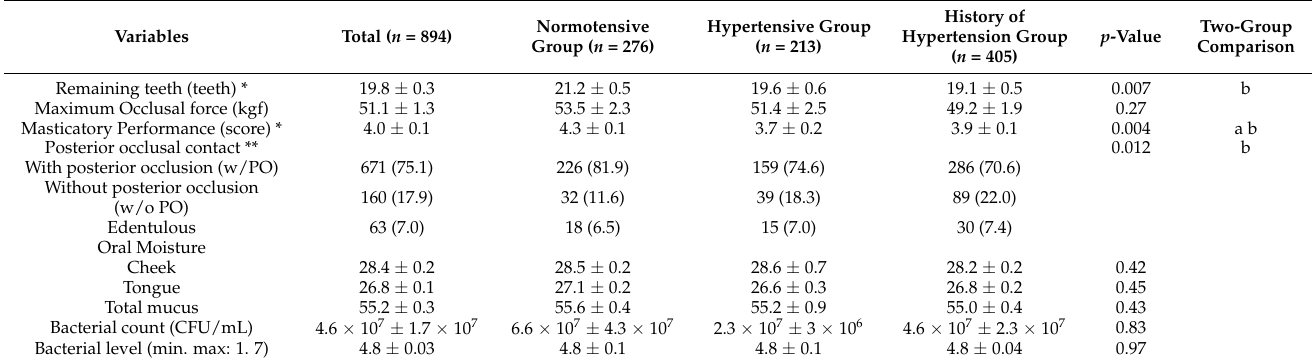
Table 2. The Relationship Between Oral Health and